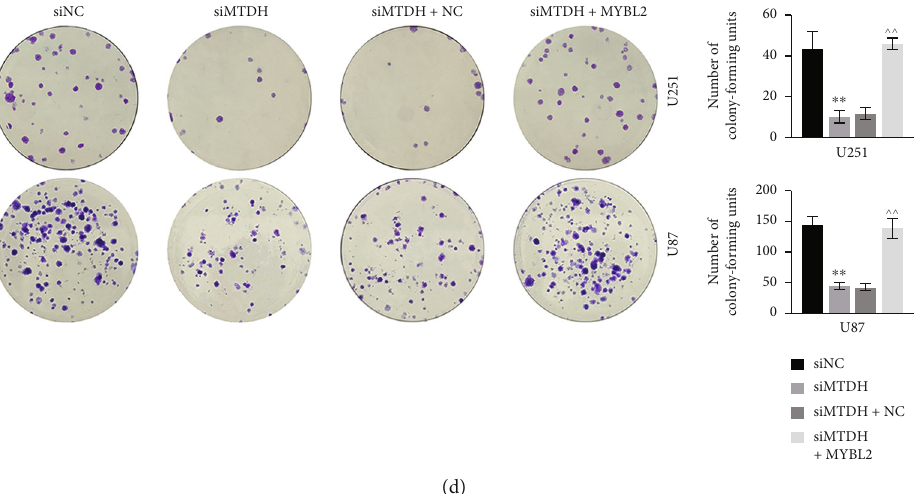
Figure 3: In U251 and U87 cell lines, the protein expression of MTDH and MYBL2 in four groups of siNC, siMTDH, siMTDH+NC, and siMTDH+MYBL2 and the proliferation, apoptosis, and clone formation of the four groups (a). Histograms of protein expression bands and relative protein expression of two genes in four groups (b). Cell proliferation in four groups (c). Cell grouping and calculated cells in four groups. Statistical graph of apoptosis rate. (d) Under the microscope, the colony formation situation of the four groups and the statistical graph of the calculated colony forming unit. N = 3 , ∗∗ p < 0 : 01 vs. the siNC group; ^^ p < 0 : 01 vs. the siMTDH+NC